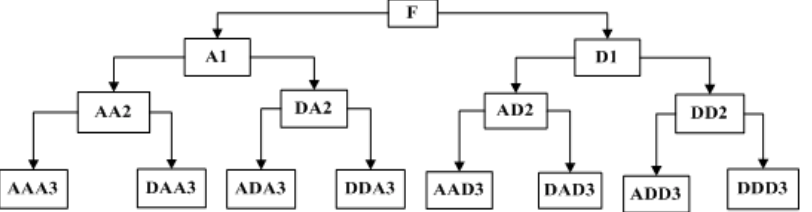
Figure 2. Schematic diagram of three-scale wavelet packets decomposition. F denotes an original signal, D1 and A1 denote the high-frequency and low-frequency component of the first scale decomposition respectively; DA2 and AA2 denote the high-frequency and low-frequency component of the second-scale decomposition, respectively.